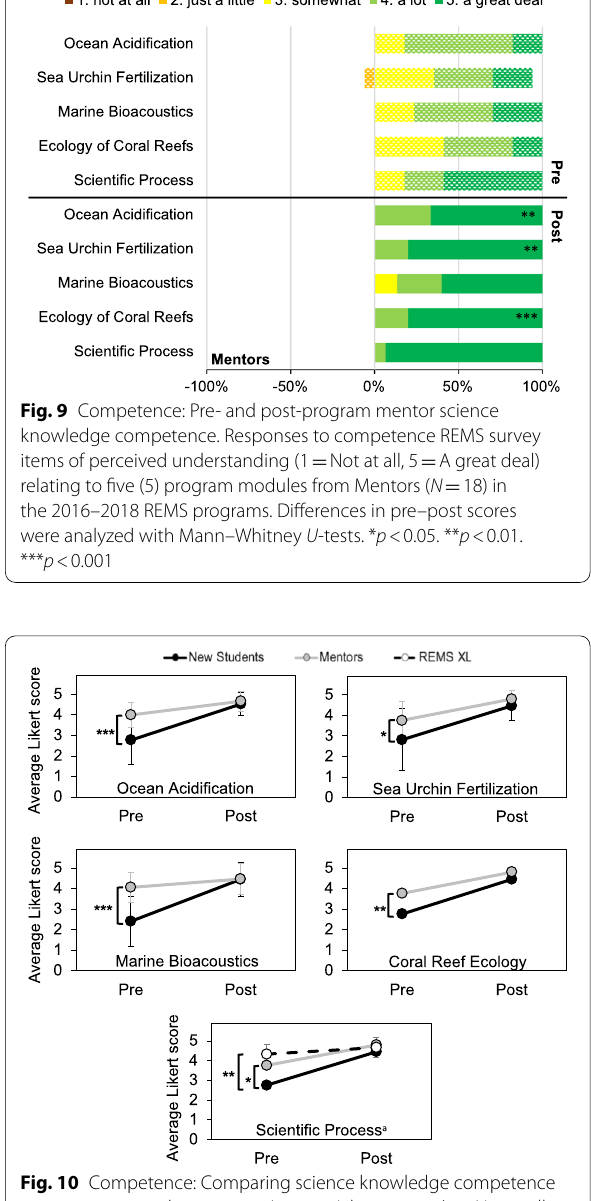
were moderately, although not significantly, correlated ( r (9) 0.58, p > 0.05). =